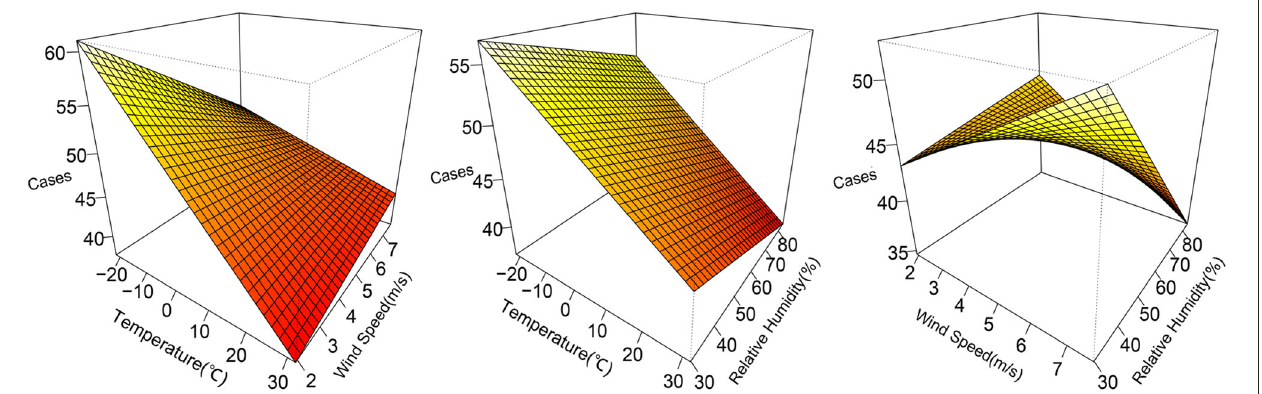
FIGURE 5 | The interaction effect of meteorological variables on PTB after a lag of 12 weeks.